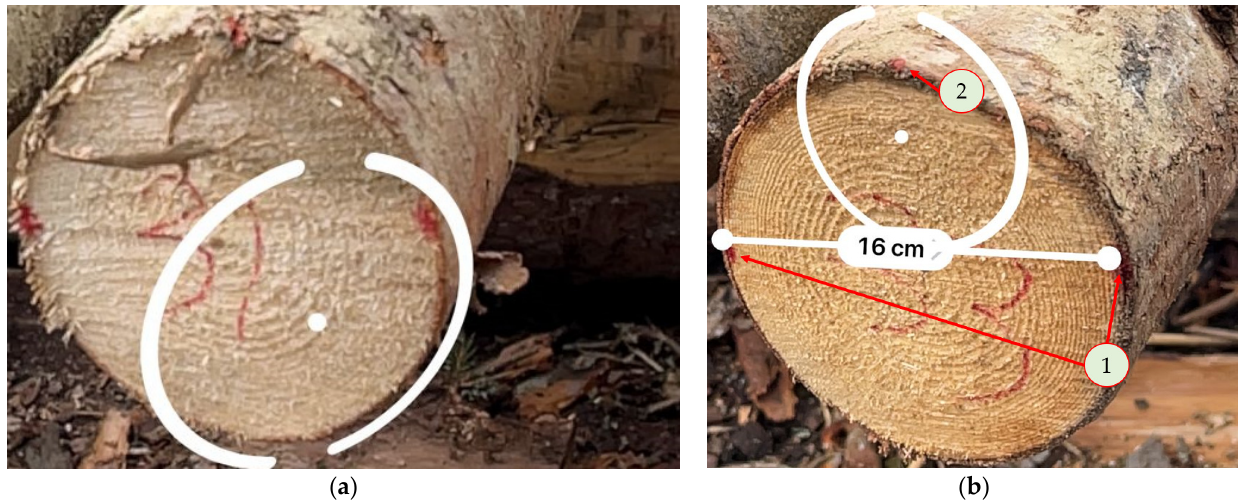
Figure 3. Examples of diameter measurements by the Measure app of iPhone in the second experi- ment (E2): ( a ) an example of log with marks placed; ( b ) an example of measurement over the log’s end diameter: 1—starting and ending points of measurement, 2—dot marked as the starting point of measurement for log length.